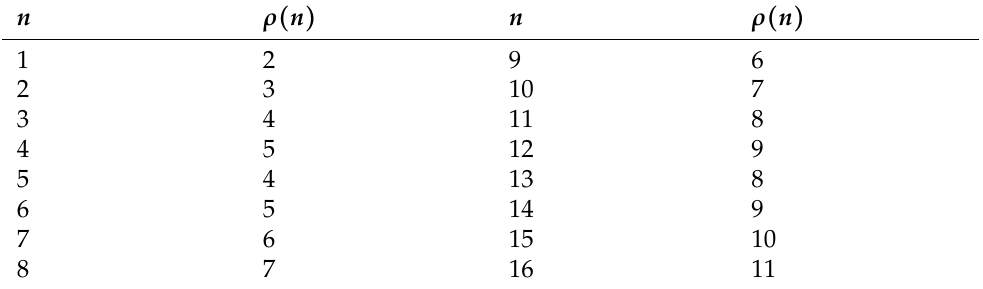
Table 1. The first 16 terms of the sequence ρ ( n )